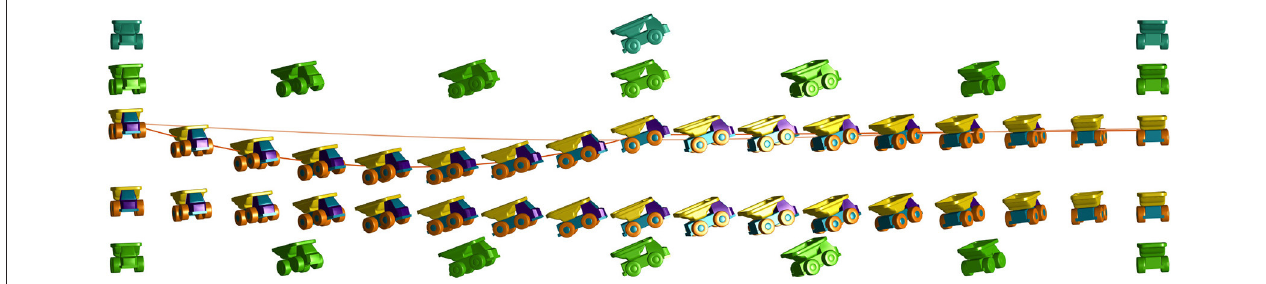
FIGURE 11 | From top row to bottom row: (1) the initial data points (cyan), (2) the control points computed by the blended Bézier approach from Gousenbourger et al. [38], (3) 17 points on the corresponding curve, where the height represents the absolute first order difference, and the comparing curve is the first order differences from our model, (4) 17 points along the resulting curve from gradient descent, and (5) the resulting control points of the curve in